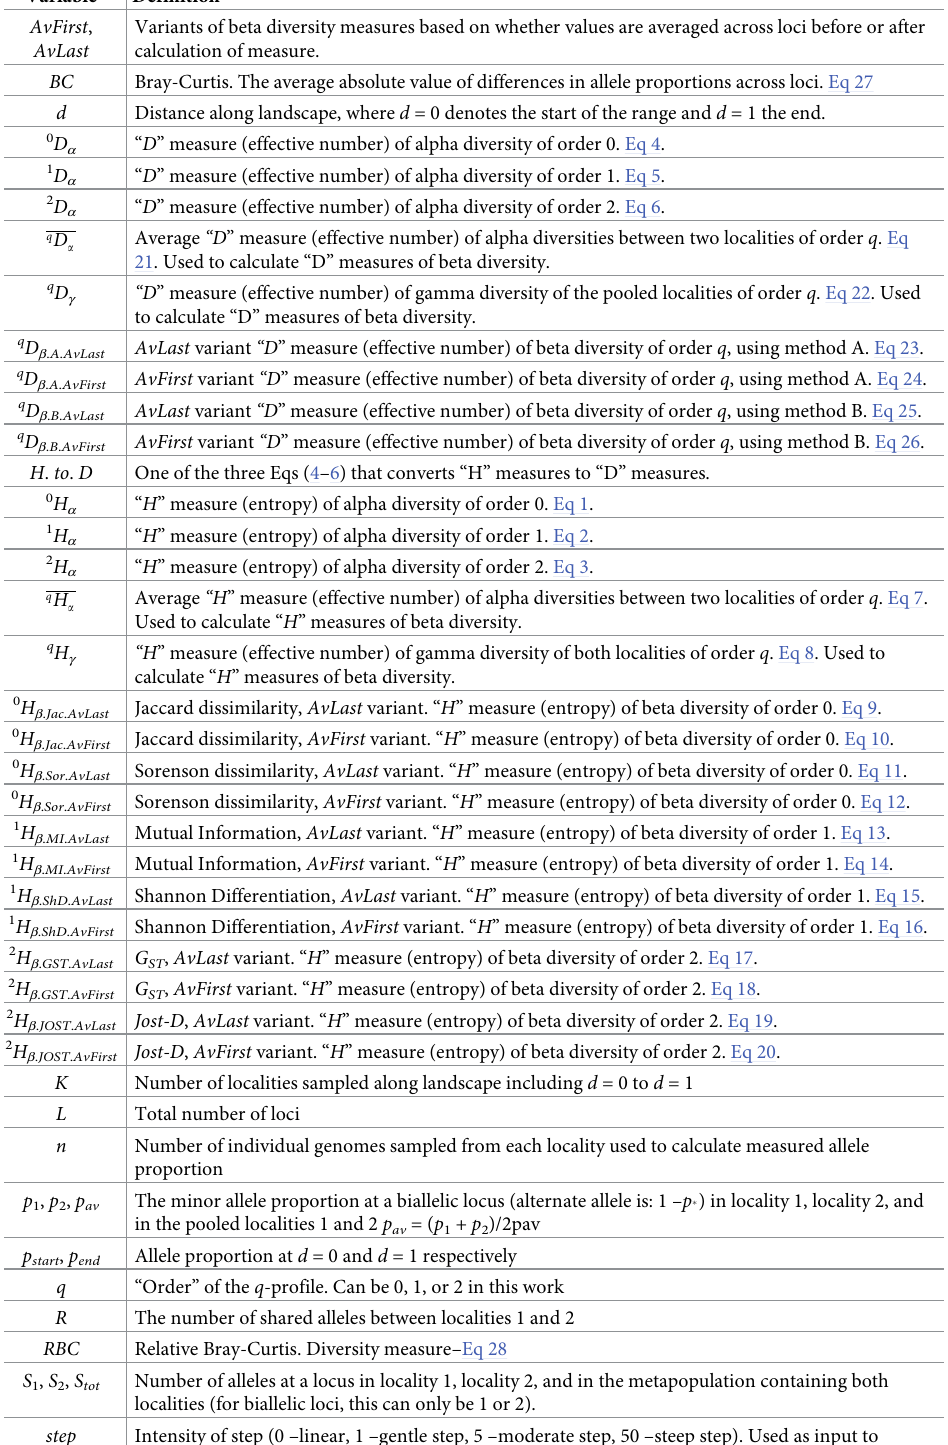
Table 1. Summary of variables and symbols used in